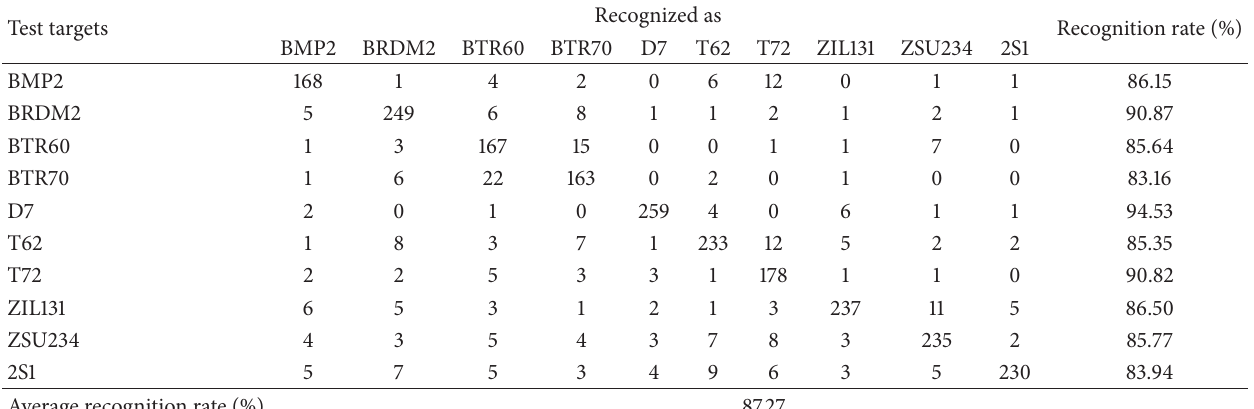
Table 1: Confusion matrix for 10-target classification (3 ∘ aperture).